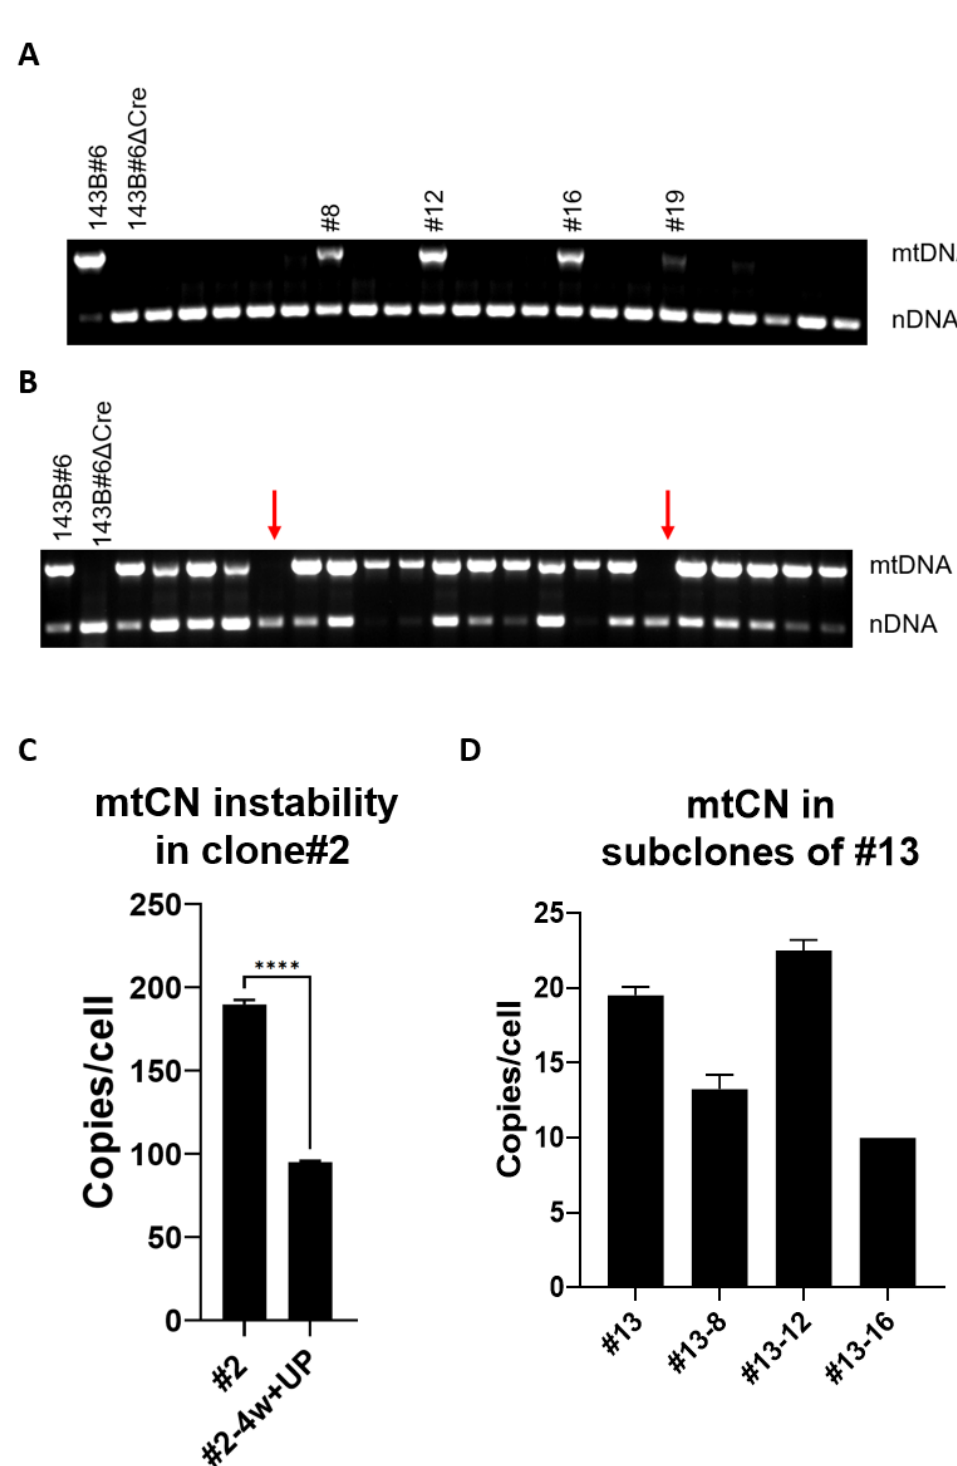
Figure 5. mtDNA instability mediated by the Ch8 TFAM variant. ( A ) Dilution cloning of clone no. 13 with a low mtCN. Approximately 19% of the resulting subclones retain mtDNA. ( B ) Dilution cloning of clone no. 20 with a relatively high mtCN. Note that mtDNA is lost in ~10% of the clones. ( C ) mtDNA instability in clone no. 2. Cells were cultivated for 4 weeks in +UP media, which is nonselective for mtDNA maintenance. Note the twofold reduction in mtCN. **** p < 0.0001, two-tailed T-test assuming unequal variance. ( D ) mtCN in subclone nos. 8, 12, and 16 of clone no. 13 (Panel A) is equal to or lower than that in clone no.